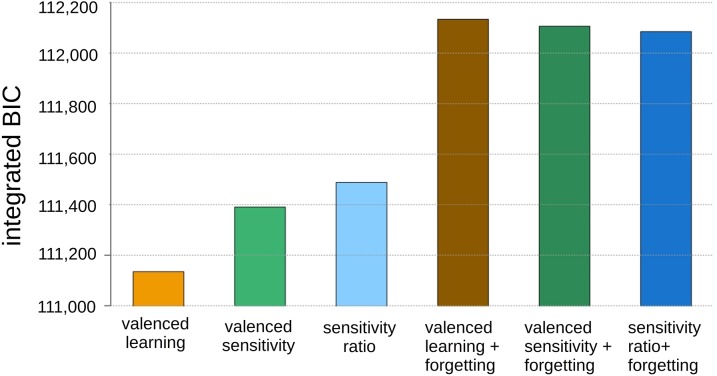
Comparison of fit quality for 6-parameter (left three) and 7-parameter (right three) models, using the baseline data.The ‘valenced learning’ (leftmost) model performs best, i.e. had the lowest integrated Bayesian Information Criterion score. Adding forgetting parameters (right three bars) worsened the fits due to the complexity penalties involved.